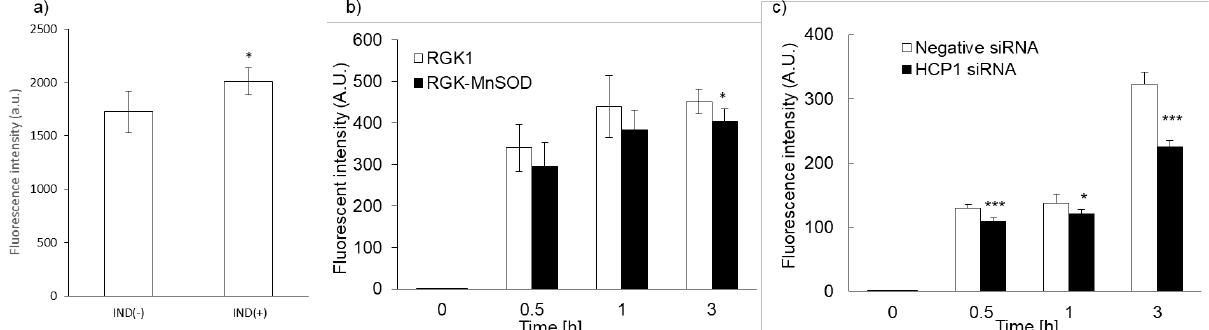
Figure 4. Relationship between PLP uptake and HCP1 expression. Cells were exposed to IND for 1 h ( a ). PLP accumulation in RGK1 was higher than in RGK-MnSOD ( b ). PLP accumulation was significantly decreased by HCP1 knockdown ( c ). Data are expressed as means ± SD ( n = 5). * p < 0.05, *** p <